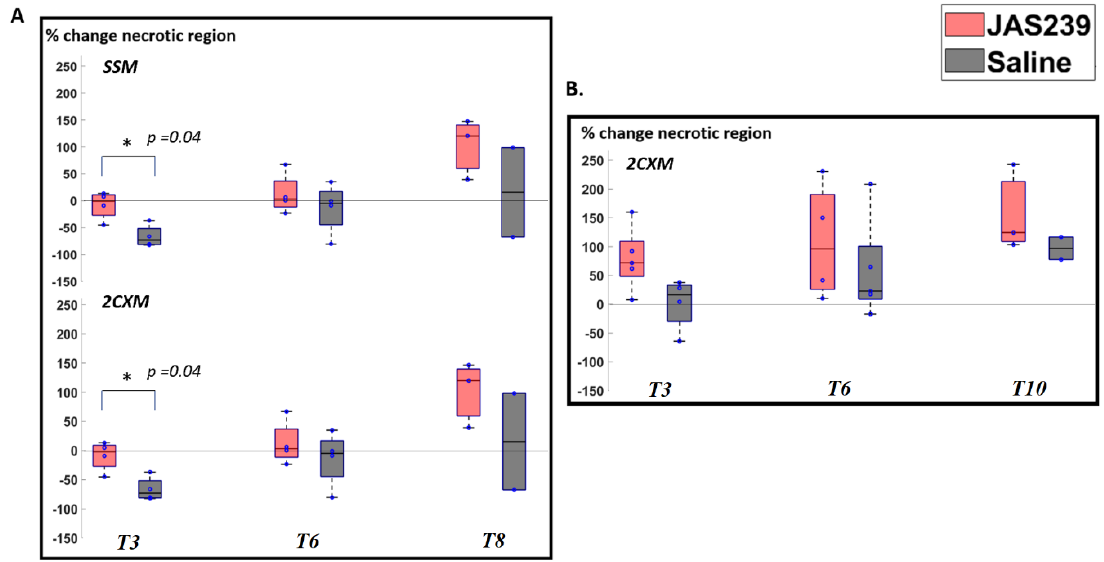
Figure 3. ( A ) Box plot for percentage change (with respect to baseline) in necrotic pixels in F98 rat GBM with JAS239 (red) and saline (grey) treatment at different time points using the SSM and 2CXM models, respectively. ( B ) Box plots showing percentage change (with respect to baseline) in GL261 mice GBM with regards to the number of pixels representing the necrotic pixels. The asterisk indicates significant difference.